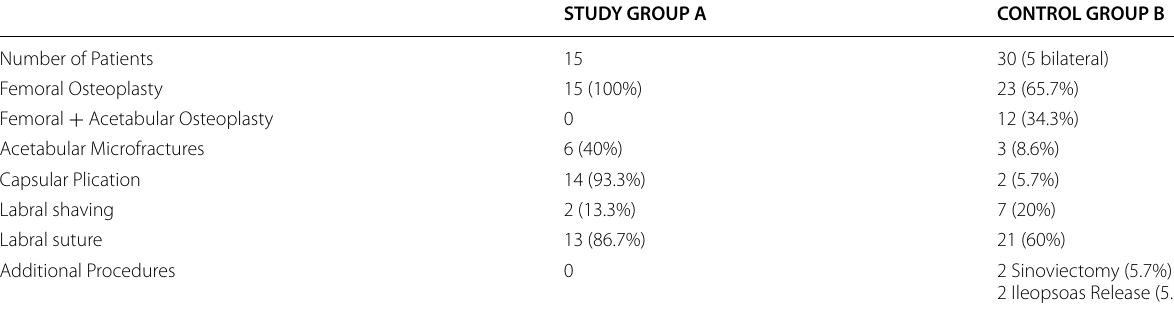
Table 2 Arthroscopic procedures performed in both groups